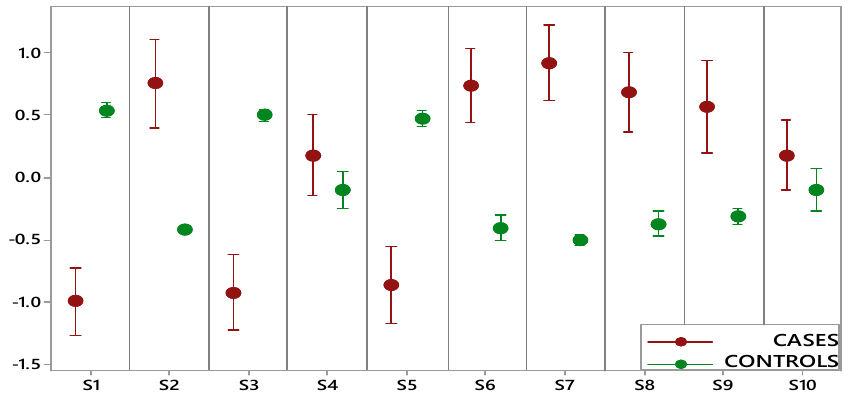
Figure 2. Interval plot of electronic nose data set for the ovarian cancer (OC) cases (red) and controls